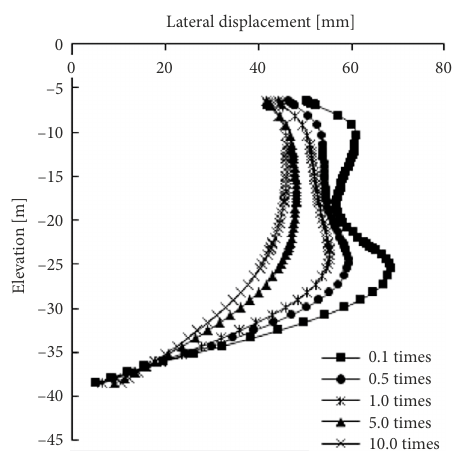
Figure 16. Effect of diaphragm wall rigidity on bending moment